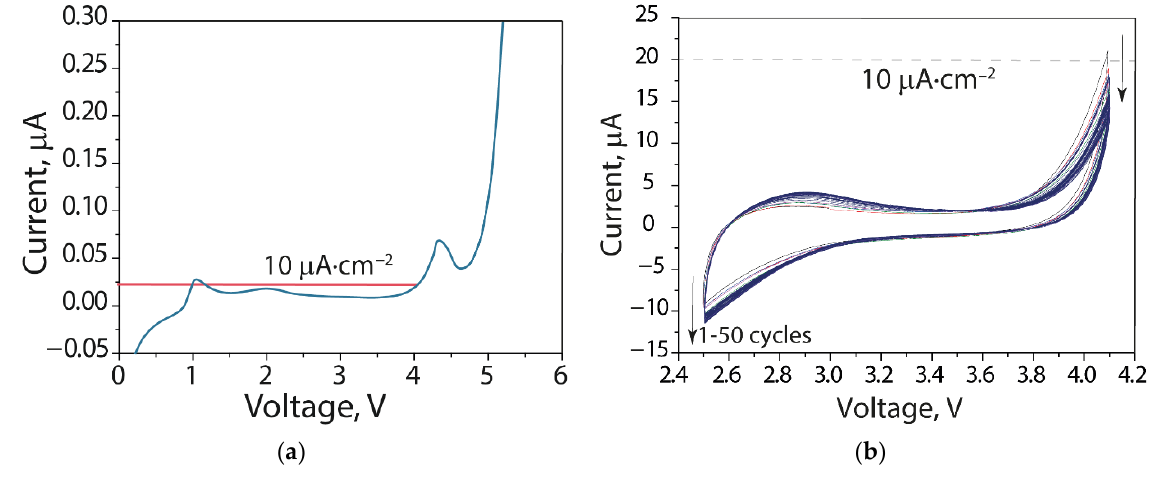
Figure 6. ( a ) Linear voltammetry of SS|Li cells with SSEBS-Ph-EC-DMA-based electrolytes in the potential range 0–5.5 V and ( b ) cyclic voltammetry in the potential range 2.5 − 4.1 V for 50 cycles.